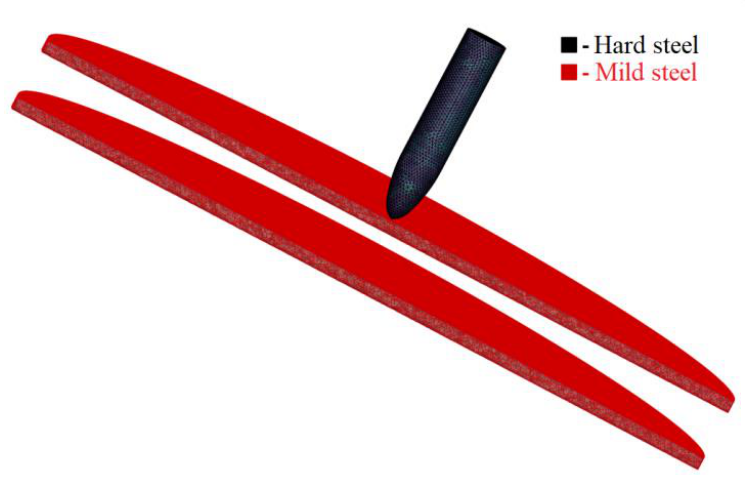
Fig. 1. The geometry of the problem of perforation of an obstacle from two steel plates spaced 24 mm